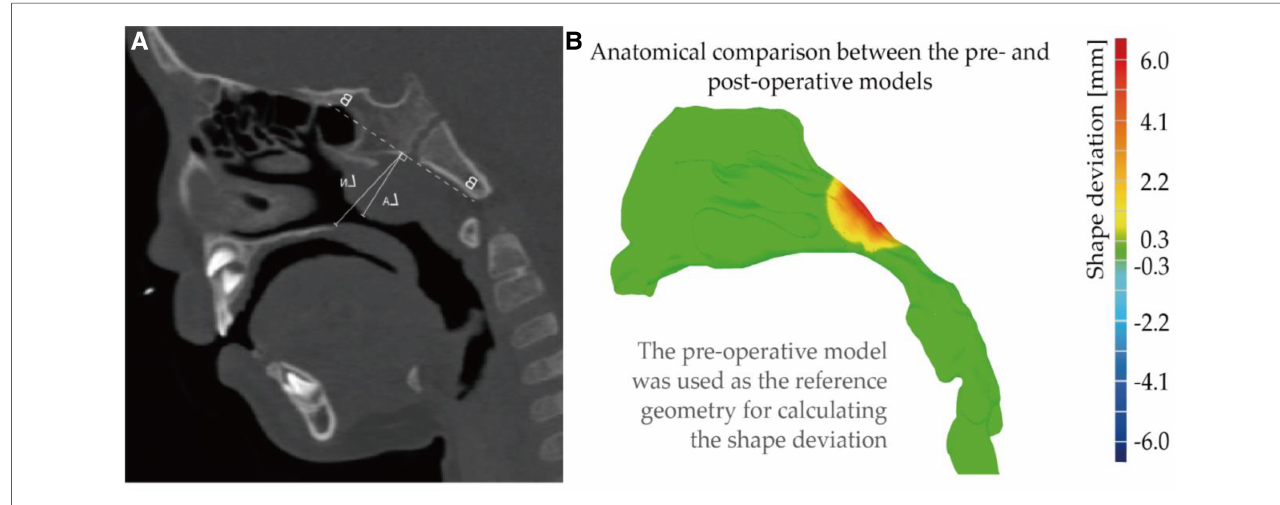
FIGURE 5 ( A ) illustrate of lateral neck x-ray(LNX) method ( B ) anatomical comparison between the pre- and post-operative models. Note, shape deviation was calculated when using the pre-operative model (original shape) as the reference